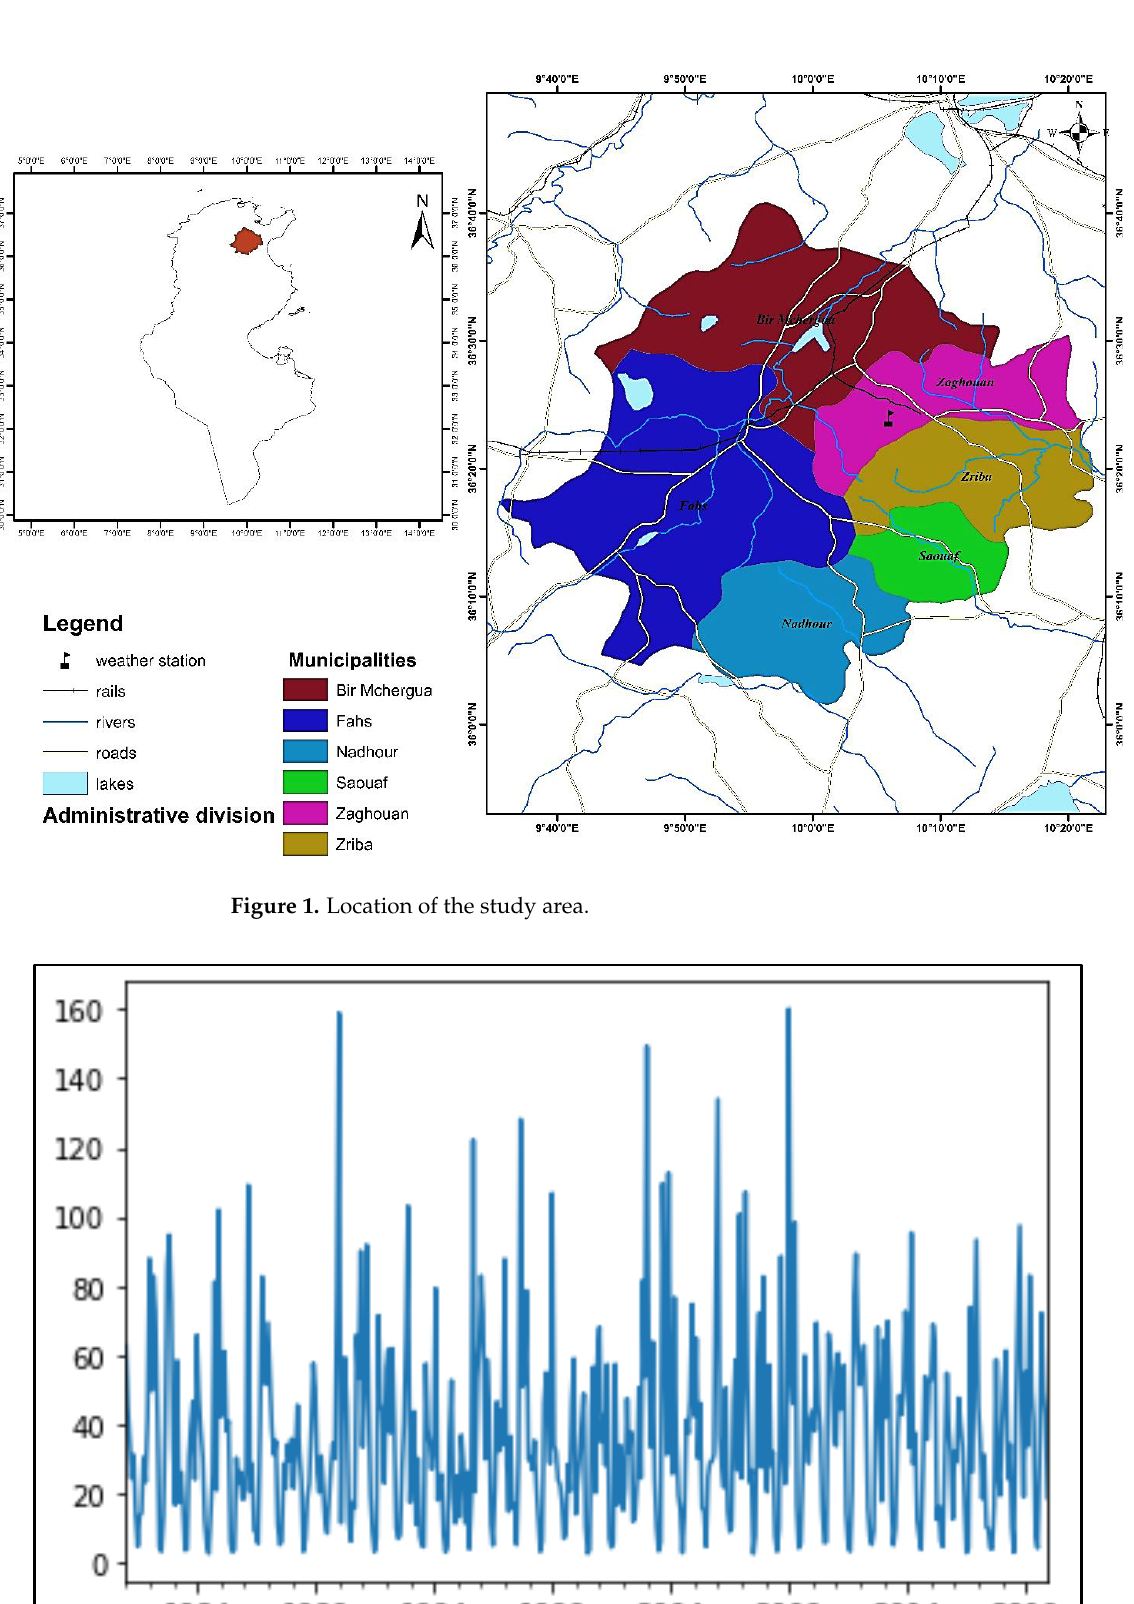
Figure 1. Location of the study area.